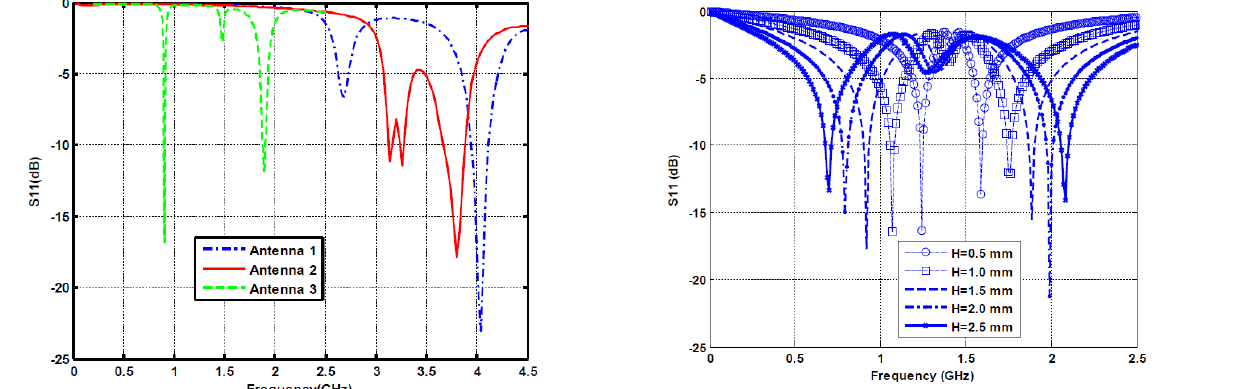
Figure 5: Comparisons of proposed antenna 3 with antennas 1 and 2.